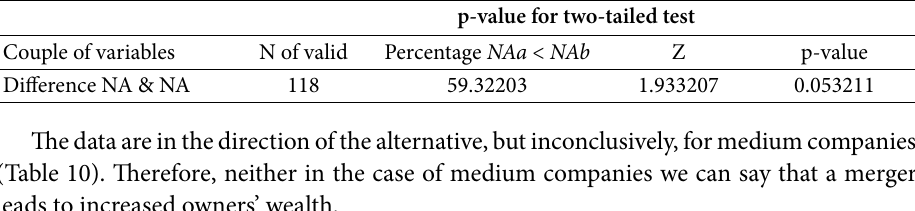
Table 10. The sign test for the category of medium companies at p < 0.05 significance level p-value for two-tailed test Couple of variables N of valid Percentage NAa < NAb Z p-value Difference NA & NA 119 47.05882 0.550019 0.582306